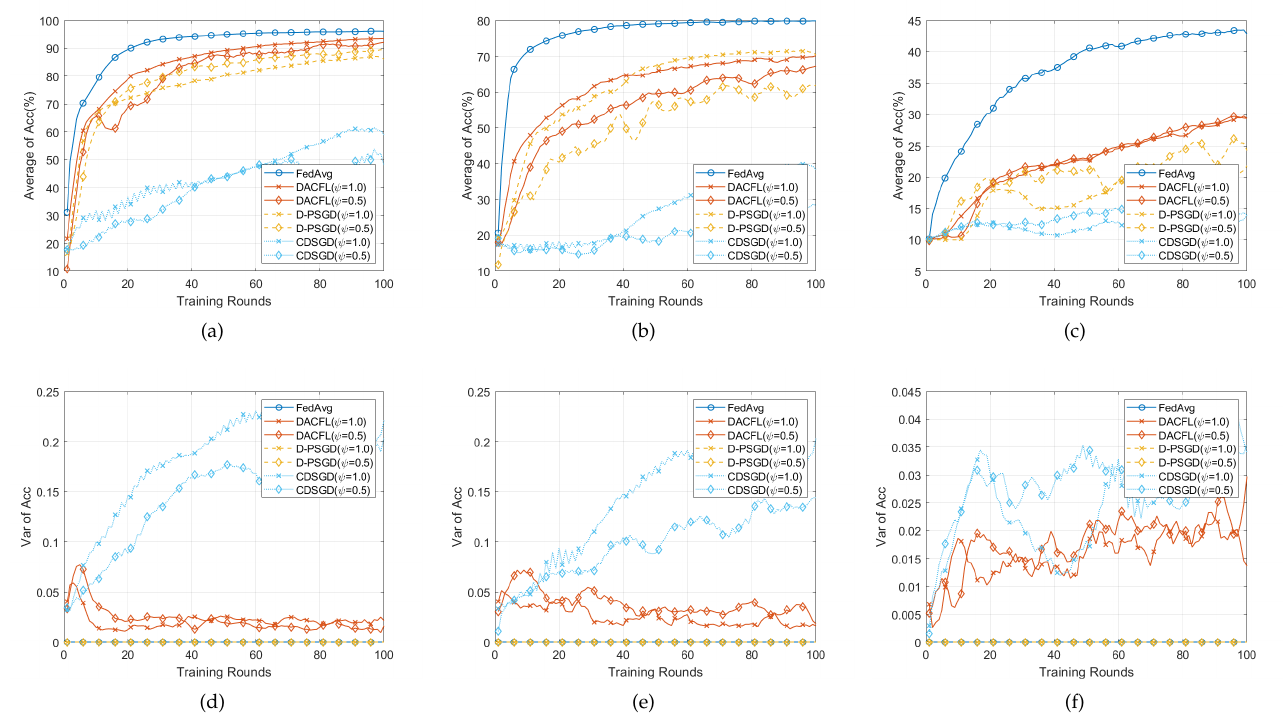
Figure 6. Performance comparison with non-i.i.d data and time-invariant topology. ( a , d ) on MNIST; ( b , e ) on FMNIST; ( c , f ) on